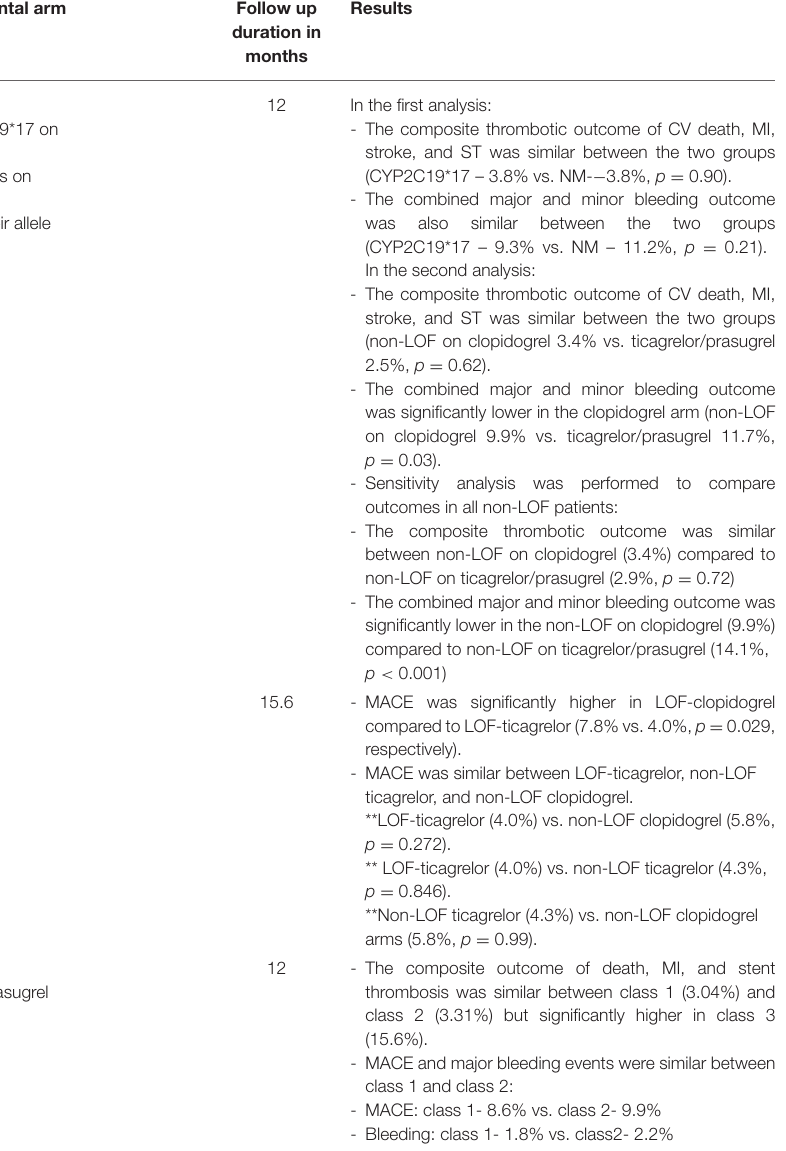
TABLE 3 | Summary of nonrandomized studied that compared clinical outcomes based on genotype-guided P2Y12